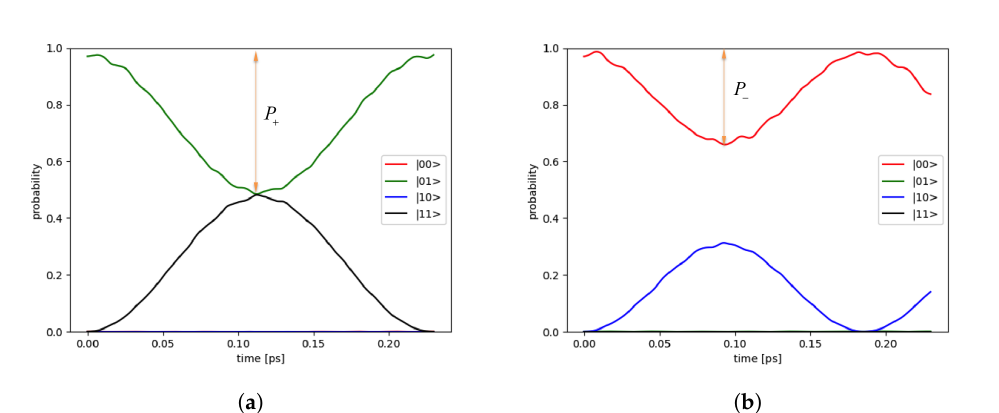
Figure 8. The dynamics of states are simulated for CNOT operation with the electronic potential model. The probability as a function of time in two qubit states are shown for ( a ) initial state | 01 (cid:105) and ( b ) initial state | 00 (cid:105) .